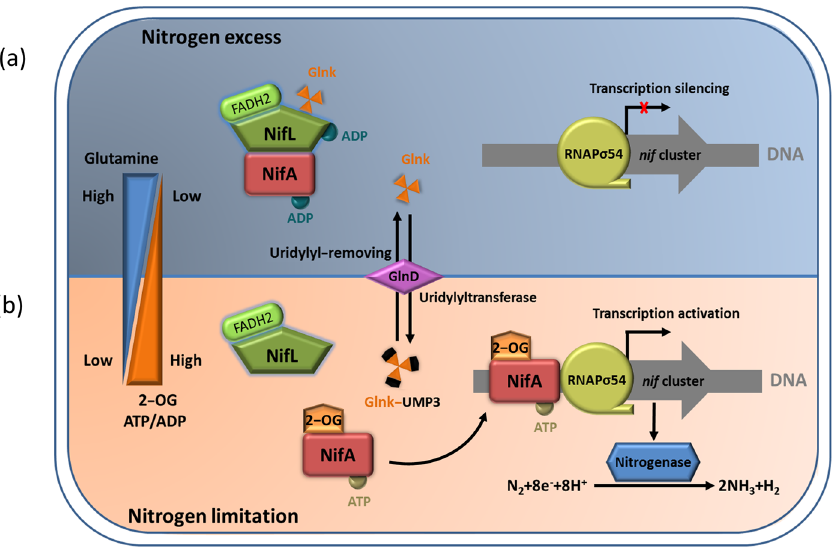
Figure 4. The NifL–NifA system’s responses to environmental and metabolic conditions in A. vinelandii . ( a ) In nitrogen–excess conditions, the binding of high concentration of glutamine to GlnD results in uridylyl removal from Glnk. NifL forms the binary complexes with NifA to inhibit NifA activation. In addition, the non–covalently modified GlnK can also interact with NifL to promote the formation of the GlnK–NifL–NifA ternary complex and inhibit NifA activity, leading to the transcriptional silencing of nif cluster; ( b ) In nitrogen–limiting conditions, high concentration of 2–OG can result in the association of NifL and GlnK in the NifA–NifL–Glnk complex. Free NifA can activate the transcription of nitrogenase gene.